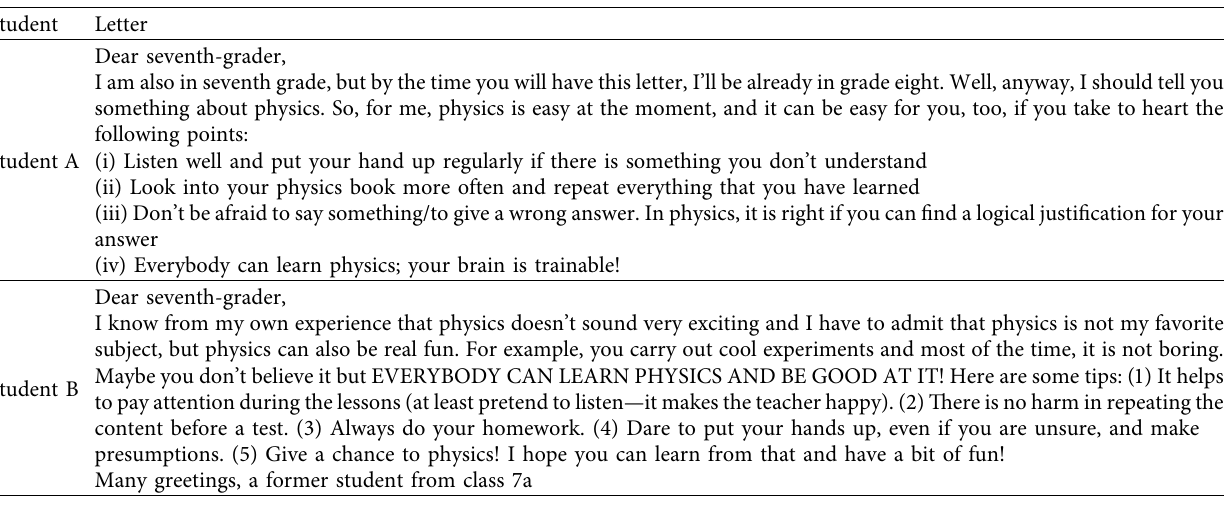
Table 5: Pen pal task (samples; translated from German).